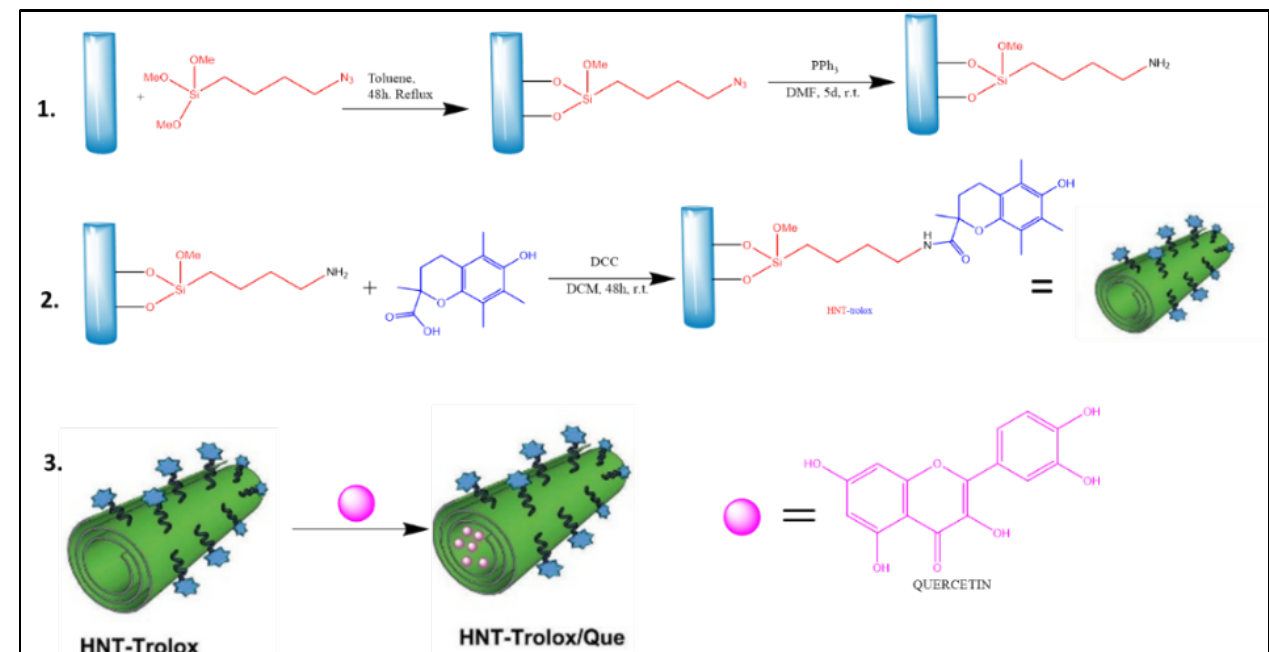
Figure 6. Trolox grafting procedure on halloysite nanotubes; the incorporation of the antioxidant quercetin in the nanotubes’ interior.